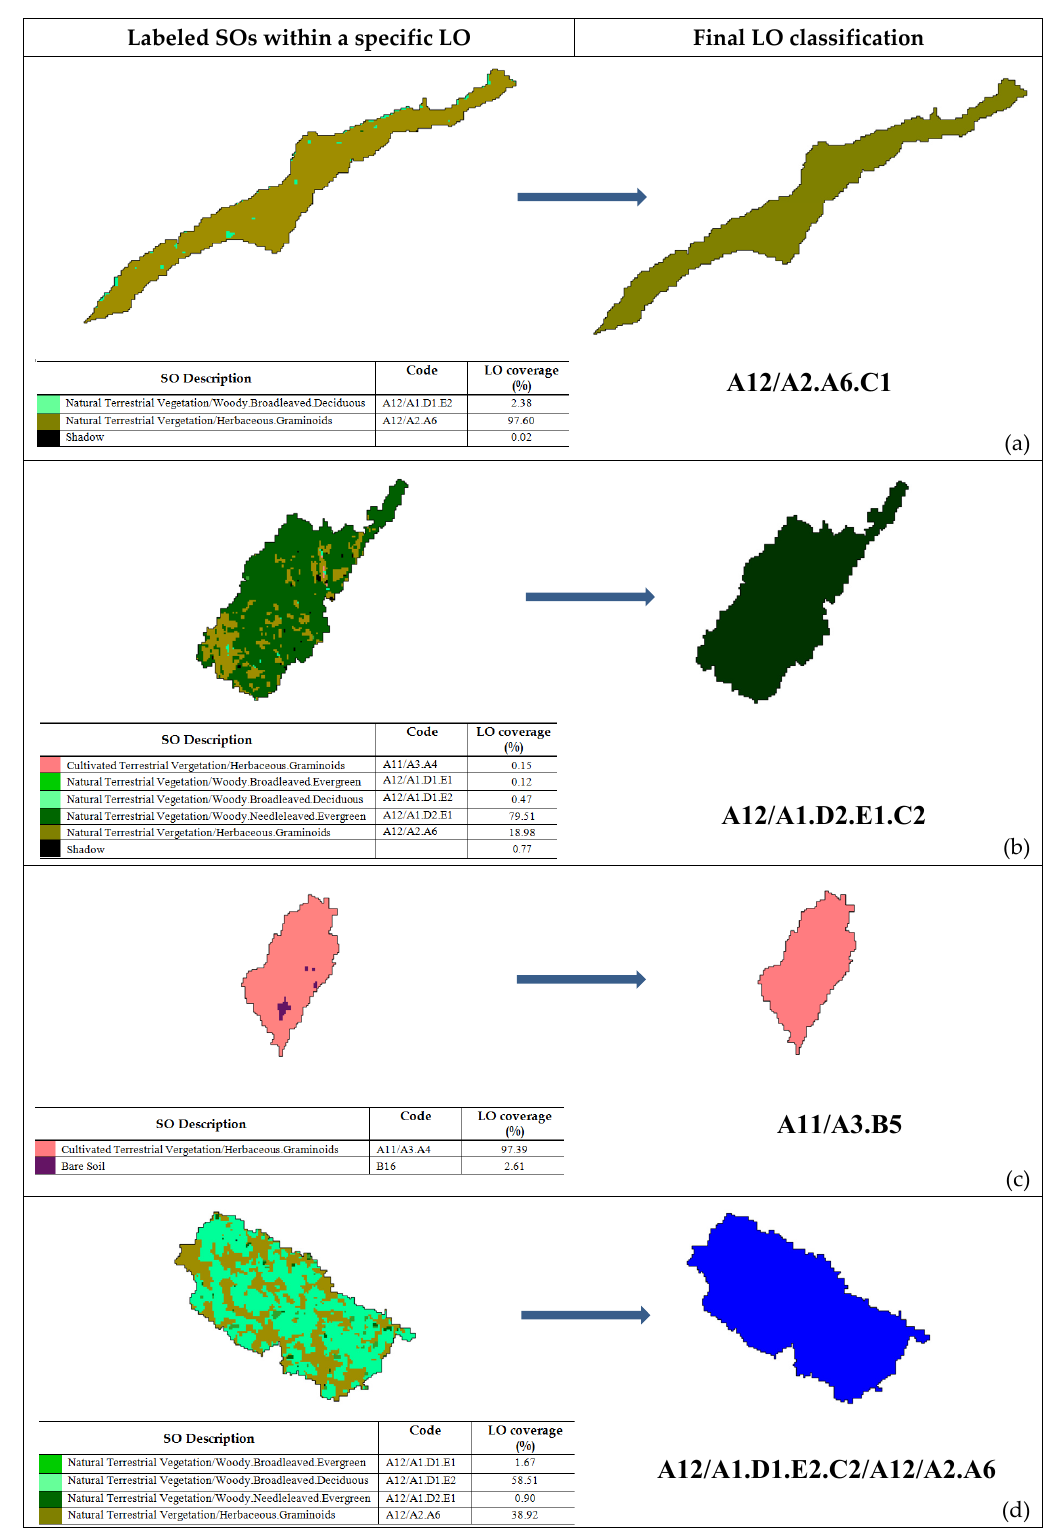
Figure 7. Examples of Large Objects (LO) classification. ( a ) example of class dominance corresponding to C1 output code; ( b ) example of class dominance corresponding to C2 output code; ( c ) example of class dominance corresponding to B5 output code; ( d ) example of class